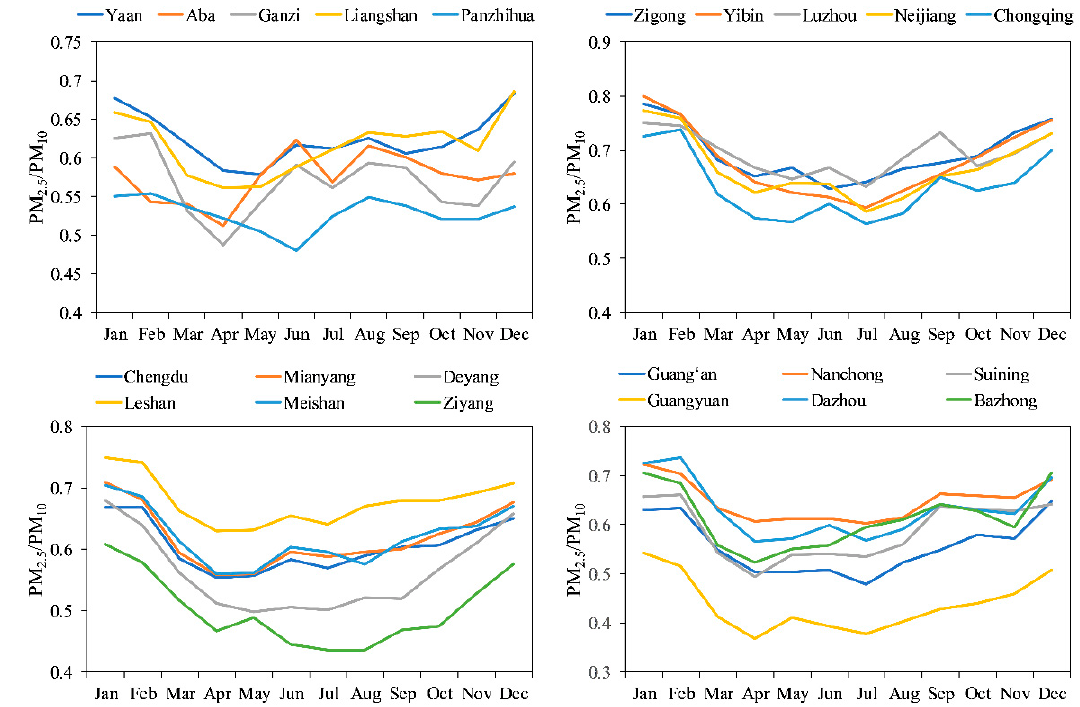
Figure 5. The monthly average PM 2.5 /PM 10 ratio of each city.